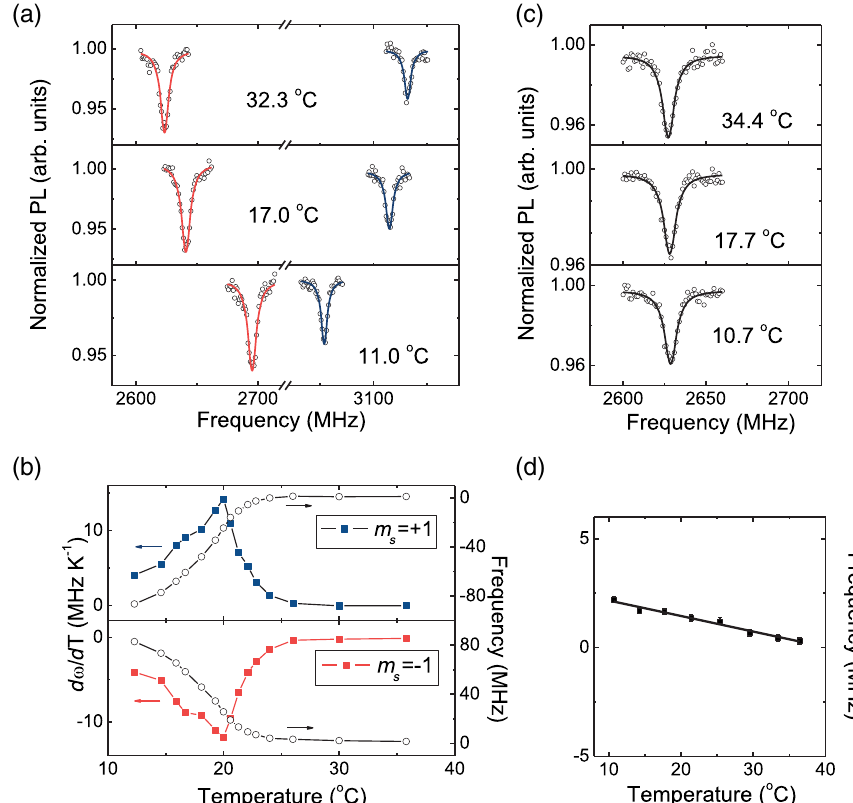
FIG. 2. Proof-of-principle demonstration of magnetic criticality enhanced temperature sensing. (a) The ODMR spectra of a NV center in a bulk diamond near a Gd particle at various temperatures near the critical point of Gd. An external magnetic field of 100 G was applied. With the criticality enhancement, the hybrid sensor shows a large spectral shift with temperature. Left (right) resonances [red (blue) lines] correspond to the m S ¼ 0 ↔ m S ¼ − 1 ð m S ¼ þ 1 Þ transitions. (b) The ODMR frequencies (black solid lines) of the hybrid sensor versus the temperature. The temperature susceptibility d ω (cid:2) / dT (square dots) of the hybrid sensor reaches (cid:2) 14 MHz/K at the critical point T C ¼ 19 °C, which is 200 times larger than that of a bare NV sensor. (c) The ODMR spectra of the same NV center as in (a), but without the Gd particle attached. The bare NV center shows only a slight spectral shift of the m S ¼ 0 ↔ m S ¼ − 1 transition under the same temperature change as in (a). In (a) and (c), the dots are experimental data and the lines are the Lorentzian fitting. (d) The ODMR frequency of the bare NV center as a function of the temperature, which has a slope of − 71 (cid:2) 2